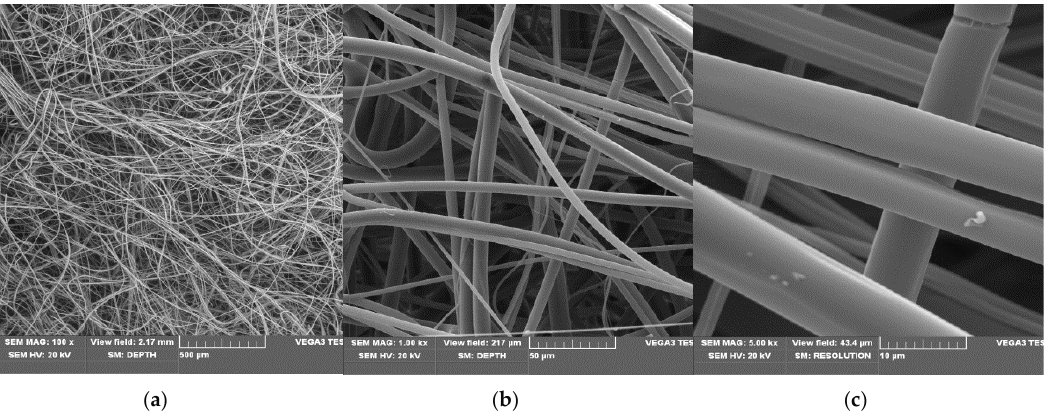
Figure 5. SEM images of starting PLA, magnification: 100× ( a ), 1000× ( b ) and 5000× ( c ). ( a ) (SEM mag.×100). ( b ) (SEM mag.×1000). ( c ) (SEM mag.×5000).